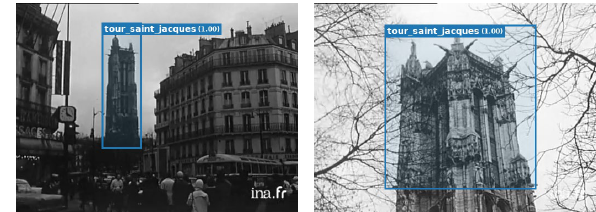
Figure 6. Example of frames with the Tour Saint Jacques correctly detected in the film footage.